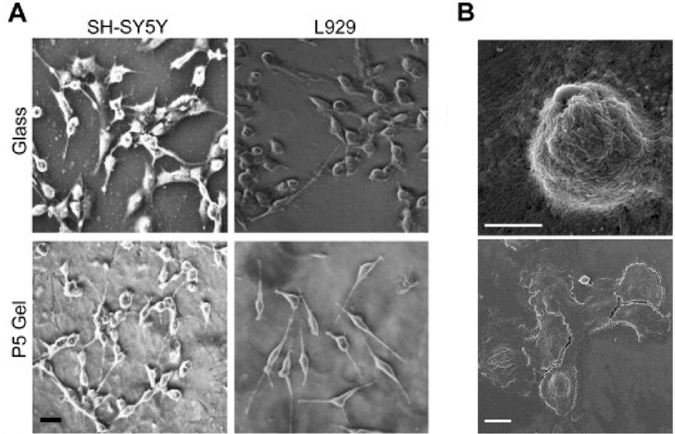
Figure 18. 2D cell culture using peptide-based hydrogels. ( A ) Phase contrast images of attached cells of SH-SY5Y cells and L929 cells grown for 24 h on glass substrates and P5 gel. Scale bar for all images are 100 mm. ( B ) SEM image depicting cell adhesion and spreading of SH-SY5Y on P5 hydrogel after 1 h (top) and 24 h (bottom) of incubation respectively. Scale bars are 1 mm ( top ) and 10 mm ( bottom ). Image adapted with permission from reference [79]. Copyright 2015 Elsevier.